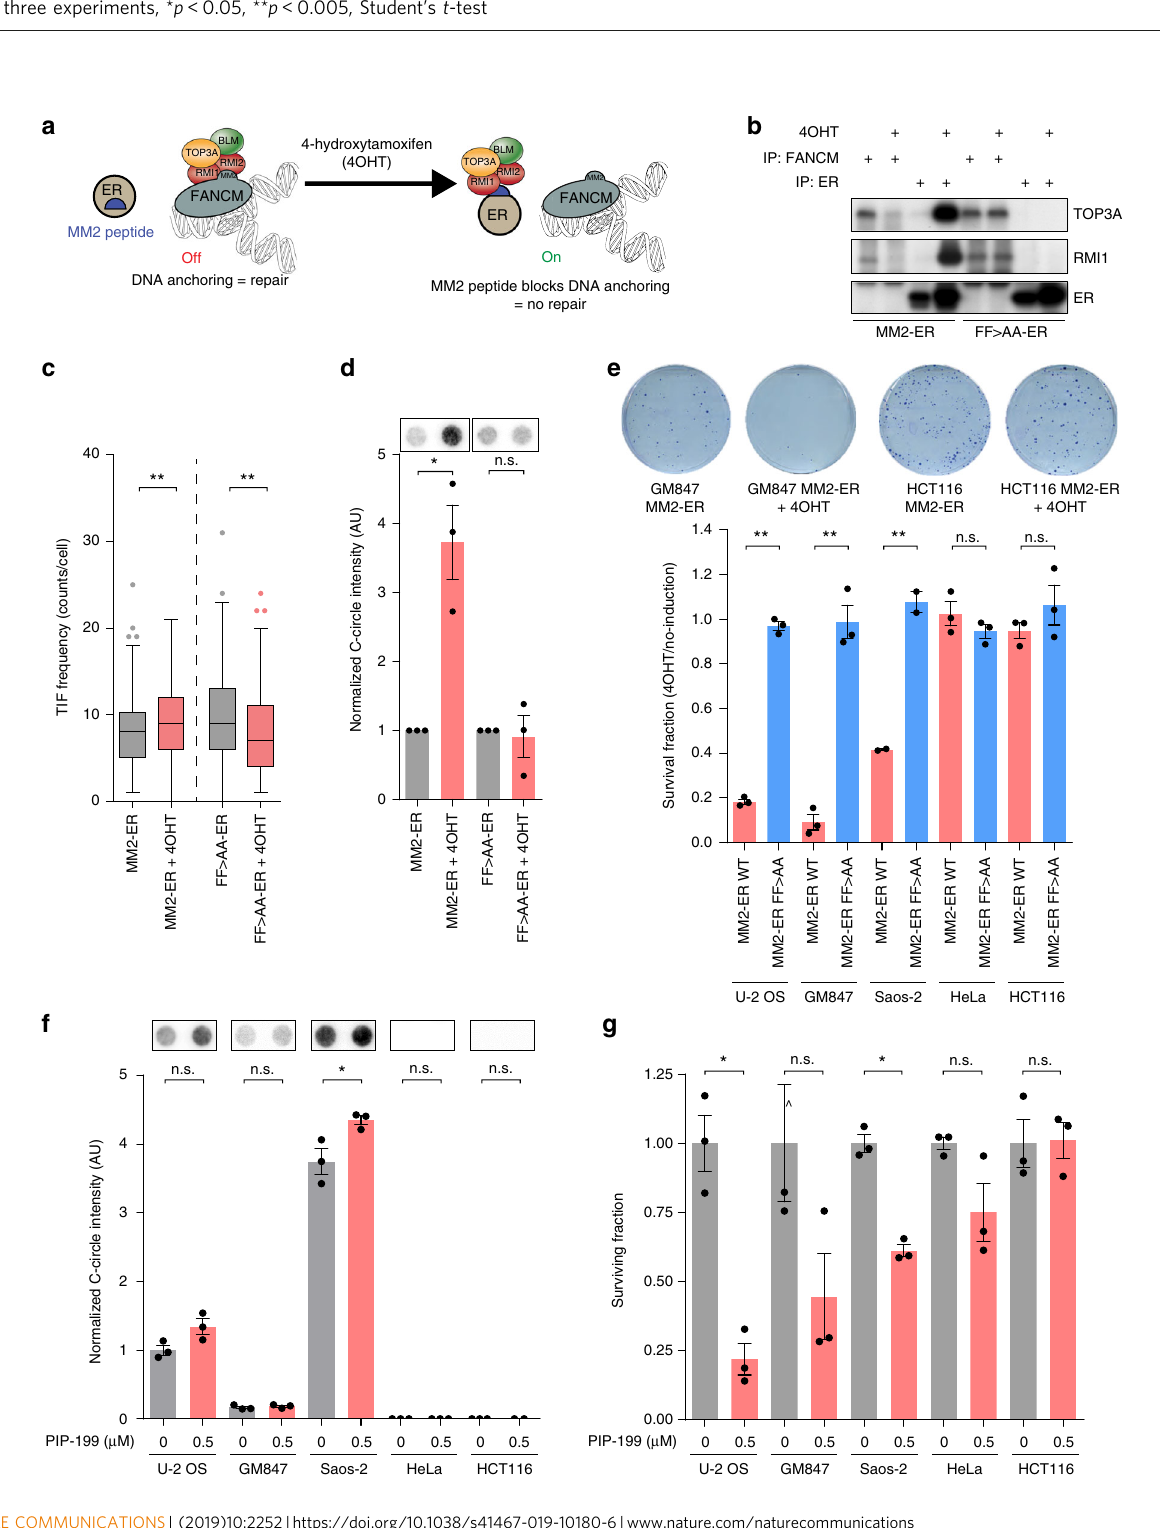
Fig. 4 ALT activity is attenuated by the replication fork remodeling capabilities of FANCM. a Schematic of FANCM domain interactions, mutations or deletions. For clarity, domains have been color-coded by functional role (bottom panel). b Quantitation of metaphase-TIFs in U-2 OS cells stably overexpressing wild-type (FANCM + ) or FANCM mutants. Scatterplot bars represent the mean ± SEM. Out of three experiments, n ≥ 110 metaphases scored for each mutant, * p < 0.05, ** p < 0.005, Mann – Whitney test. c Quantitation of fragile telomeres in U-2 OS cells stably overexpressing wild-type (FANCM + ) or FANCM mutants. Scatterplot bars represent the mean ± SEM. Out of three experiments, n > 100 metaphases scored for each mutant, * p < 0.05, ** p < 0.005, Mann – Whitney test. d Representative dot blots and quantitation of C-circle assays in U-2 OS cells stably overexpressing wild- type (FANCM + ) or FANCM domain mutants. C-circles were normalized to the mean of vector control. Error bars represent mean ± SEM from n = 3 experiments, * p < 0.05, ** p < 0.005, Student ’ s t -test. e Single molecule analysis of telomeric extension events (left panel) and length of extension events (right panel) in U-2 OS cells stably overexpressing wild-type (FANCM + ) or FANCM domain mutants. Error bars represent mean ± SEM of n ≥ 350 fi bers out of three experiments, * p < 0.05, ** p < 0.005, Student ’ s t